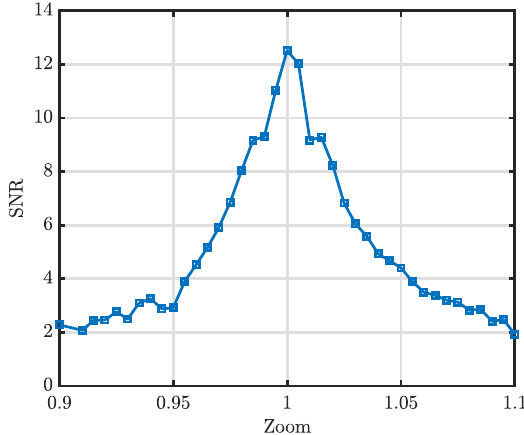
Figure 6. Signal-to-Noise ratio with different zoom. (Correct zoom is